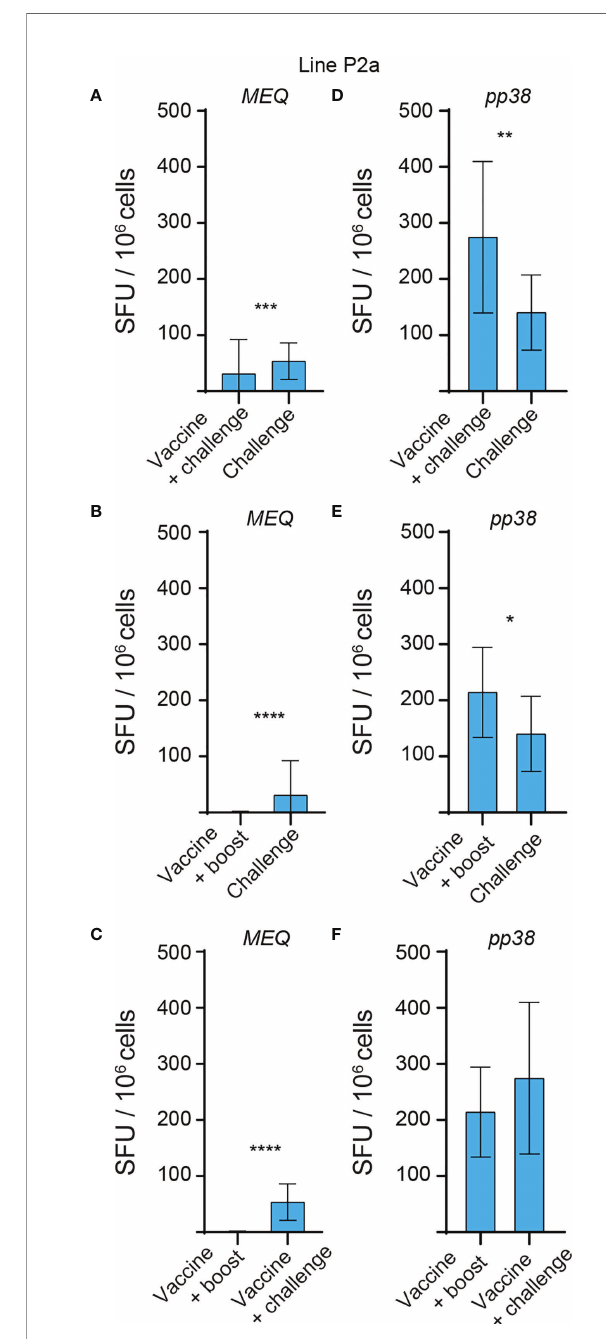
FIGURE 5 | Higher frequencies of MEQ and pp38 -speci fi c T cell responses in vaccine-challenge and vaccine-boost groups in line N chickens at 2 weeks post last inoculation. The frequencies of antigen-speci fi c IFN-gamma producing T cells, detected using a standard ex vivo ELISPOT assay, to (A – C) MEQ and (D – F) pp38 derived peptide pools in the different experimental groups of line N chickens at 2 weeks post last inoculation are graphed. The results are presented as SFU per 10 6 cells and shown as mean ± SD. Non-parametric Wilcoxon tests (Mann – Whitney) was used to assess normal distribution and test signi fi cance. **** ( P ≤ 0.001) indicates as statistically signi fi cant.